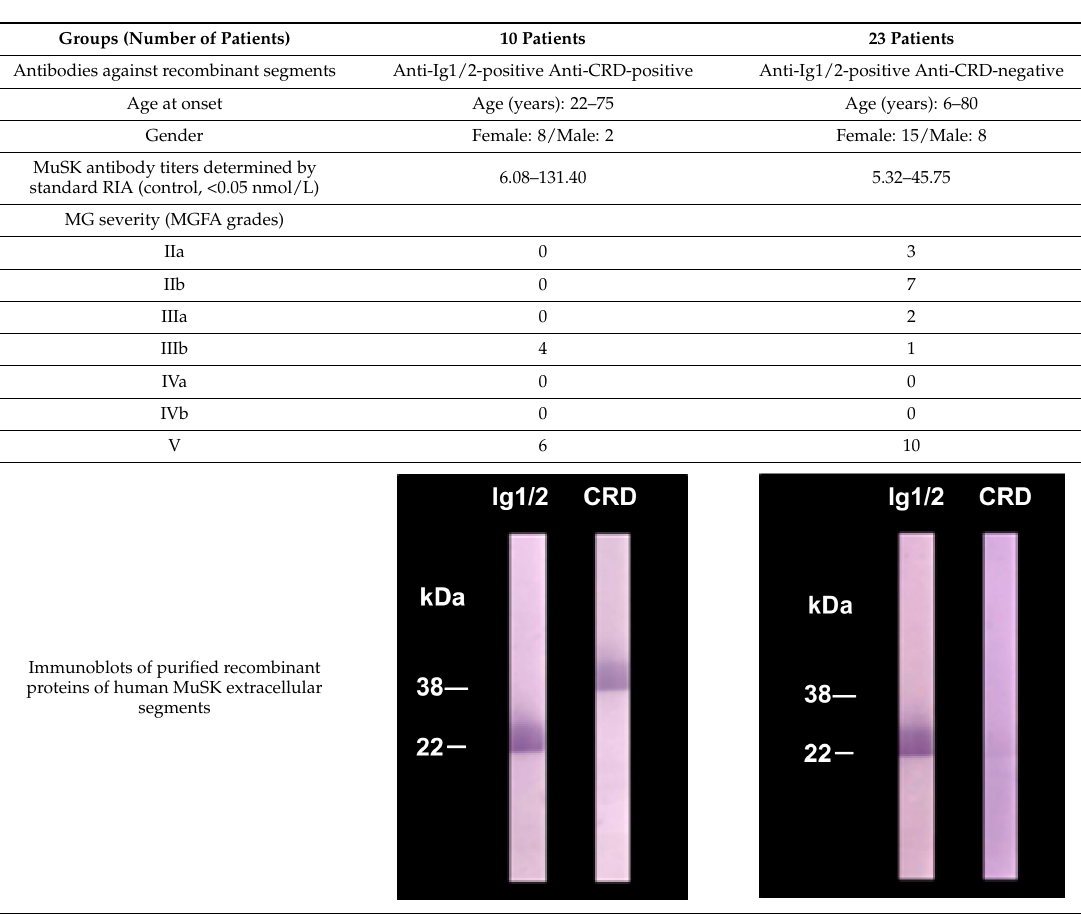
Table 1. Study of antibodies against muscle specific tyrosine kinase (MuSK) extraceullar segment (immunoglobulin-like 1 and 2 (Ig1/2) domains and cysteine-rich domain (CRD)): clinical and immunological profiles of 33 patients positive for MuSK (extracellular full-length) antibodies and negative for nicotininc acetylcholine receptor (AChR) antibodies. Groups (Number of Patients)